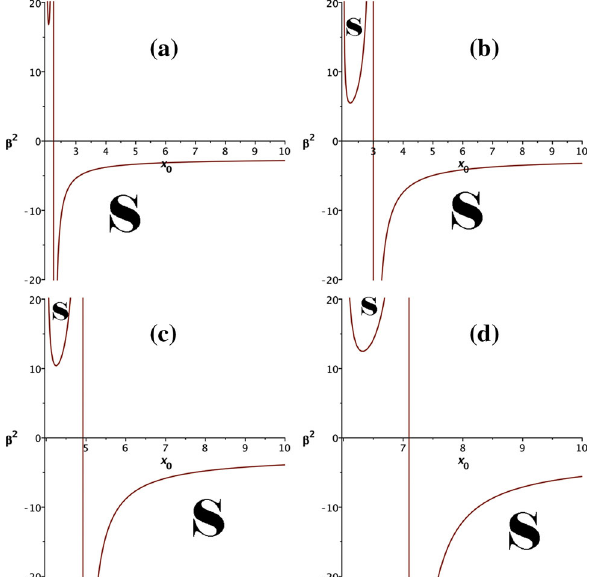
( a ) equal to zero will have terms which include γ . If V (cid:2)(cid:2) 0 eff